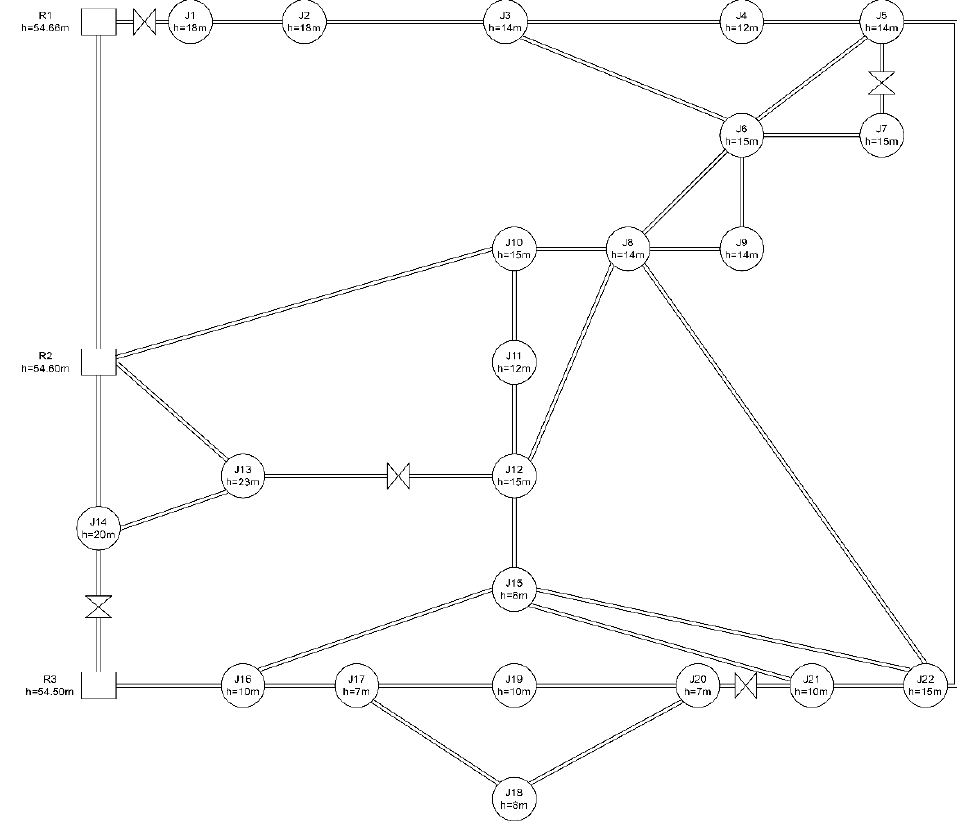
Figure 10. Network with PBV to simulate micro hydropower.